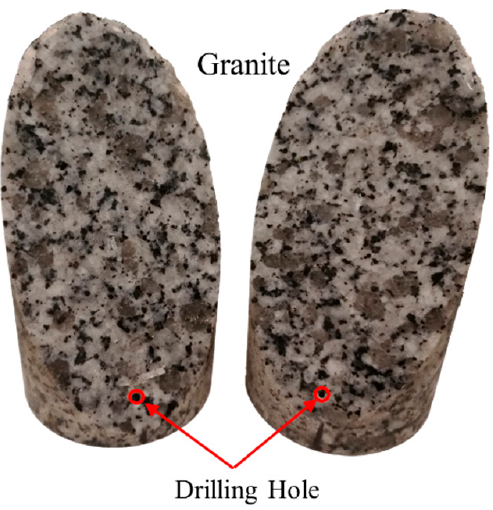
Figure 1. A granite sample with a 30° inclination to the vertical axis.